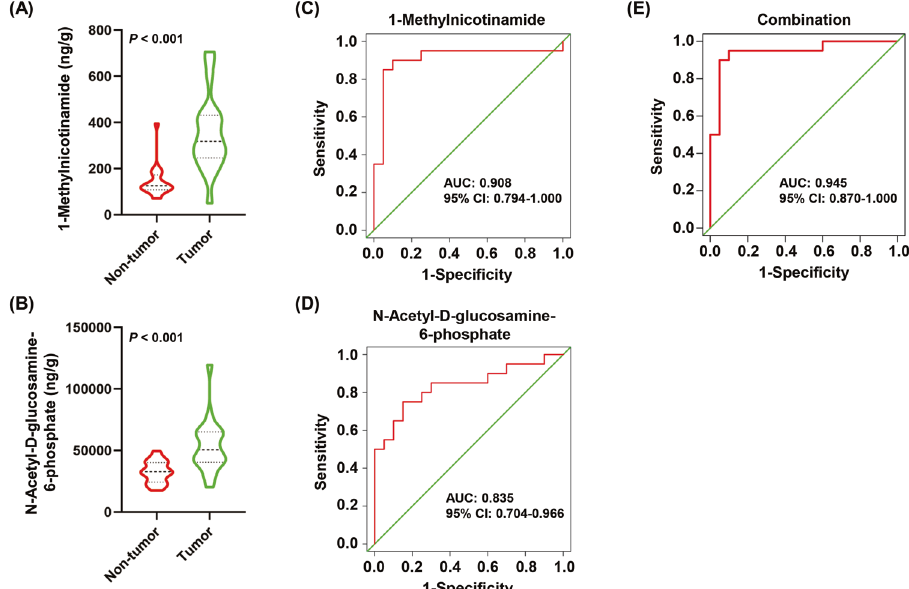
Fig. 5 Validation of metabolite biomarkers for distinguishing between gastric tumor and non-tumor tissues. A The concentrations of 1-methylnicotinamide was compared between tumor tissues and matched non-tumor tissues from 20 patients with gastric cancer (GC). B Comparison of the concentration of N -acetyl-D-glucosamine-6-phosphate between 20 paired GC tumor and non-tumor tissues. C – E ROC analysis for 1-methylnicotinamide ( C ), N -acetyl-D-glucosamine-6-phosphate ( D ), and the combination of the two metabolites ( E ). ROC, receiver operating